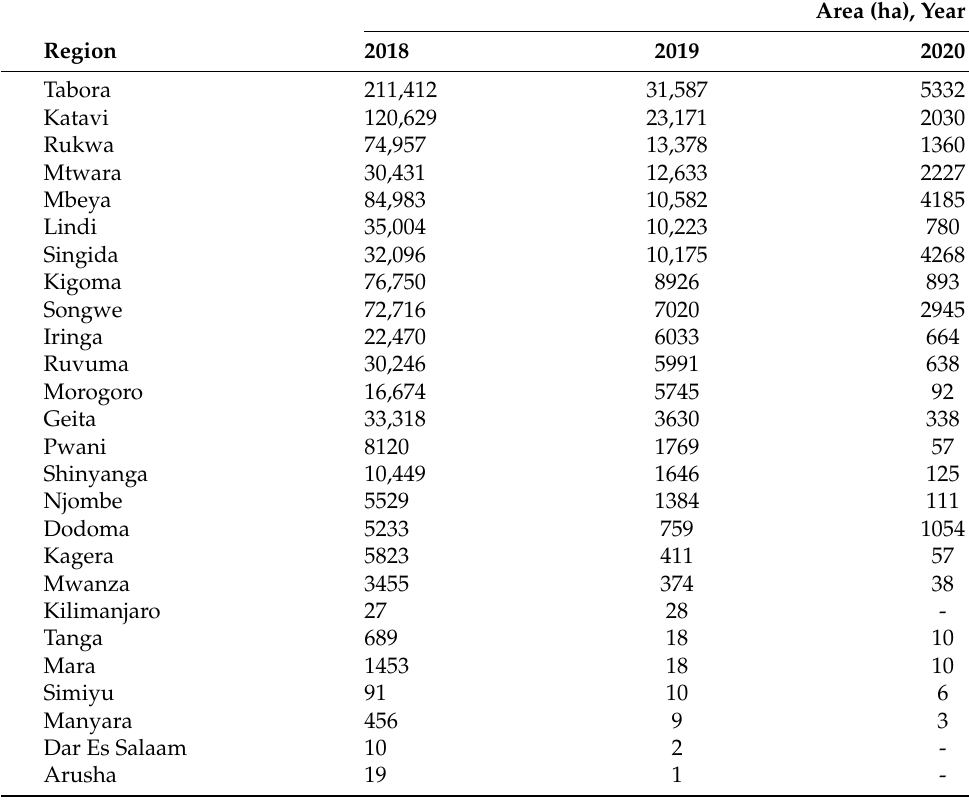
Table 13. Summarise forest change extent by region in